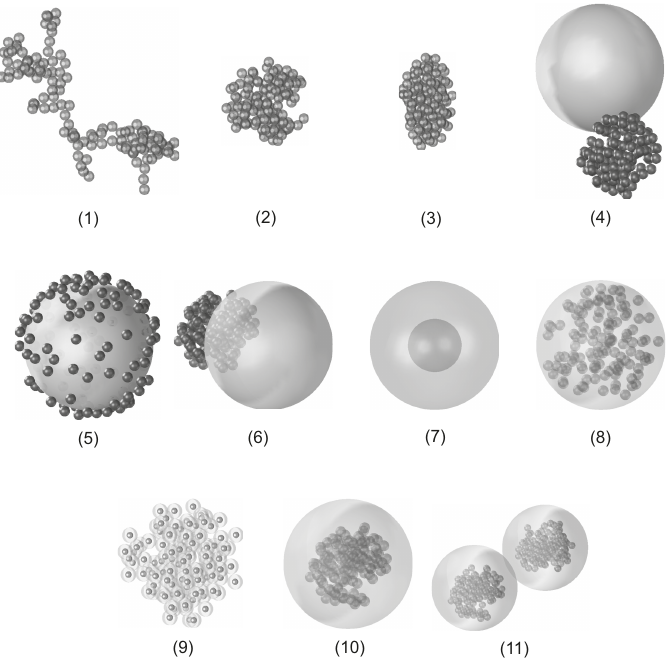
Figure 1. Model morphologies of soot and soot-containing particles considered in this study.